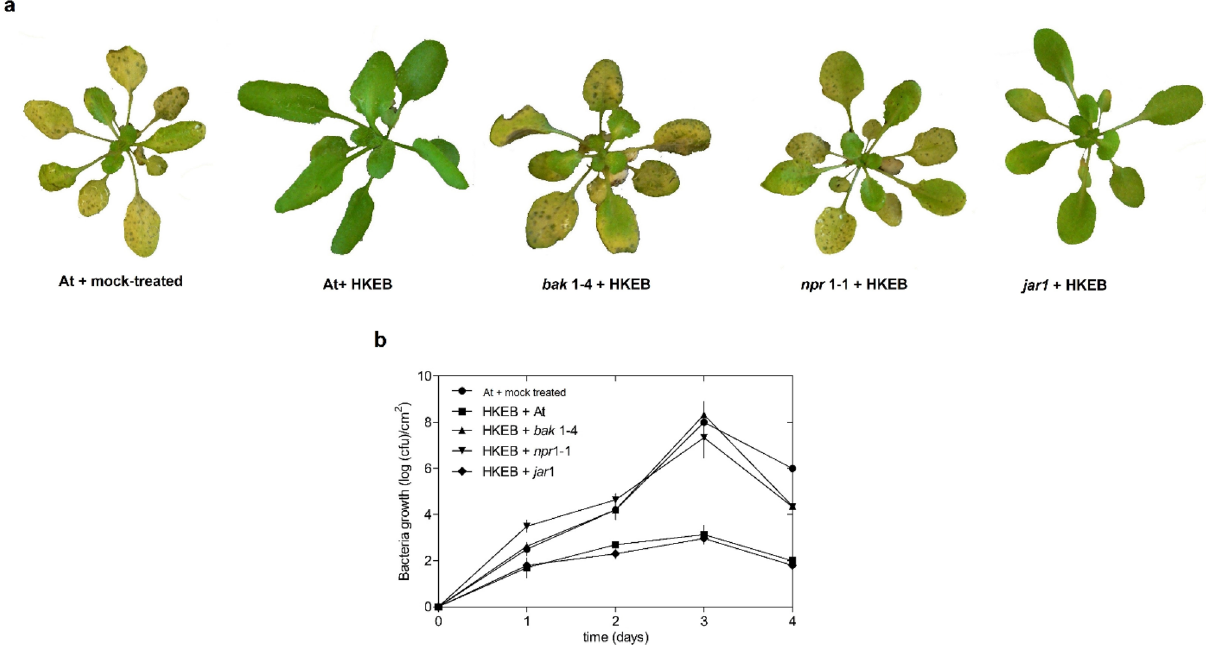
Figure 9. The defense responses that are triggered by B. aryabhattai HKEB treatment are dependent on BAK1 and the SA pathway against the biotrophic pathogen Pst . ( a ) Phenotypes of bak1-4, npr1-1 and jar1 mutant plants that were treated with HKEB. ( b ) Bacterial growth in mutant plants that were treated with HKEB. The in planta bacterial populations were determined daily. The multiplication of Pst in Arabidopsis leaves was plotted on a log scale. The bars represent the mean values and standard errors of the means (n = 10). The experiments were replicated three